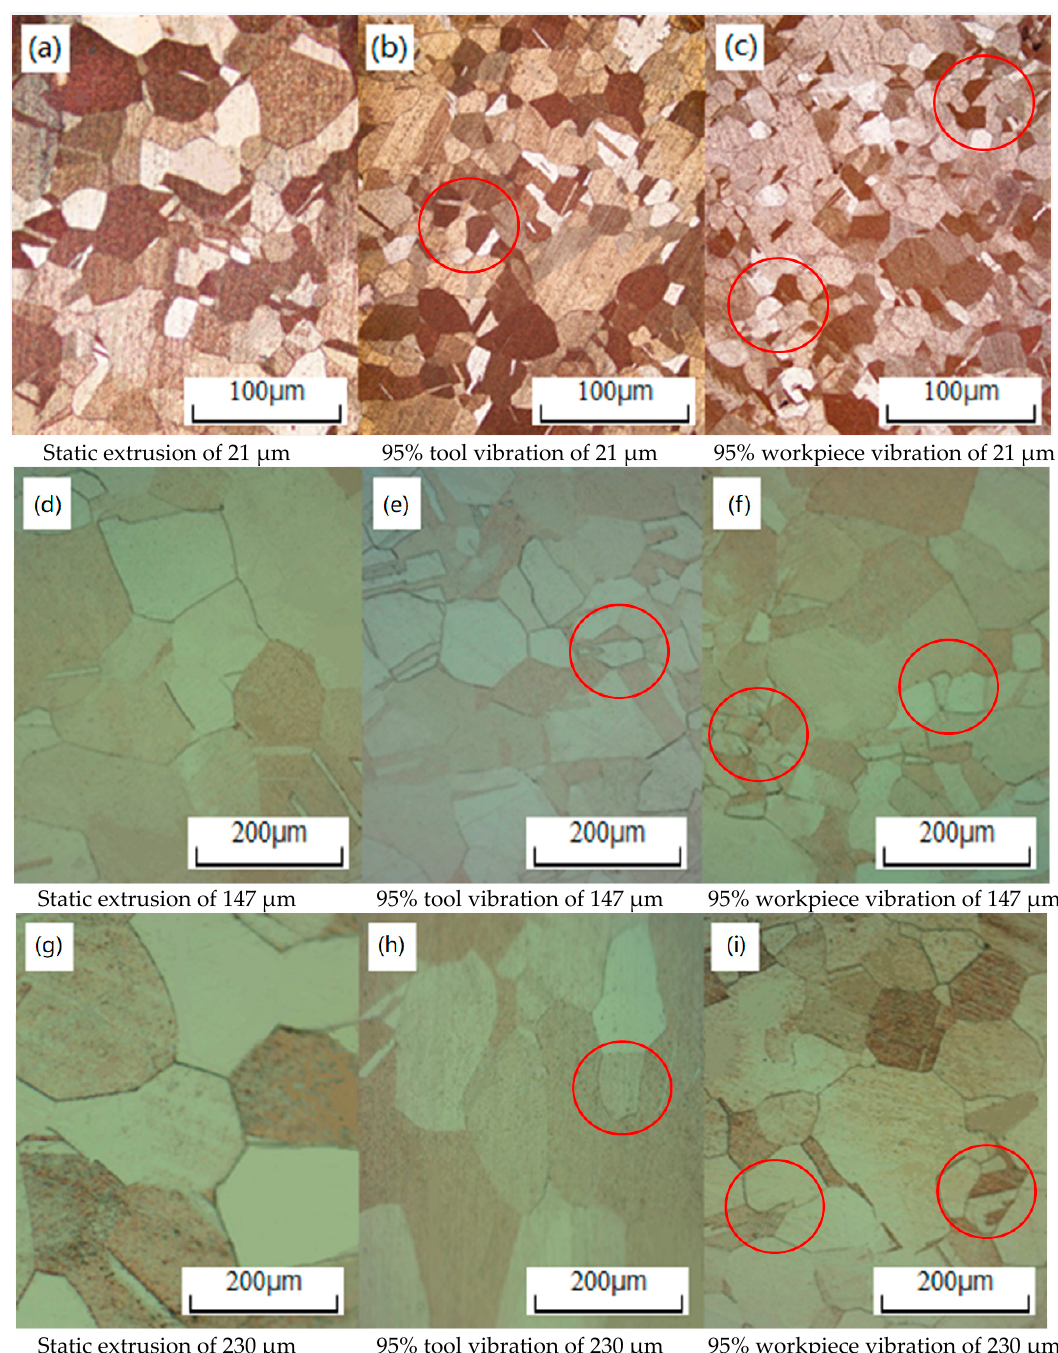
Figure 11. Microscopic microstructure of micro-extruded specimen with different vibration modes.